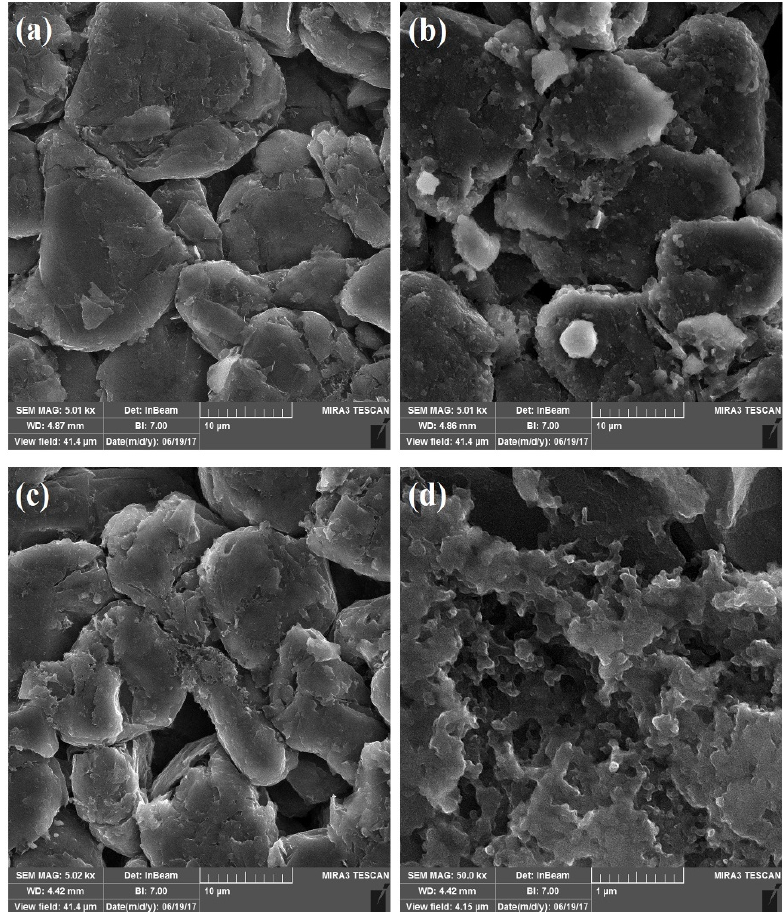
Figure 6. The SEM images that were taken from the graphite electrodes: ( a ) before cycling (fresh electrode), ( b ) after cycling in the electrolyte without the PVS, ( c , d ) after cycling in the electrolyte with the PVS at two different magnifications.